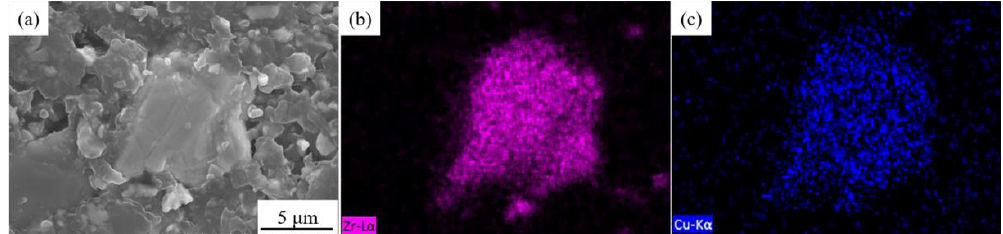
Figure 2. ( a ) SEM image and ( b , c ) energy dispersion spectra (EDS) mapping results of Zr and Cu of cross-section of Zr-Cu powder.